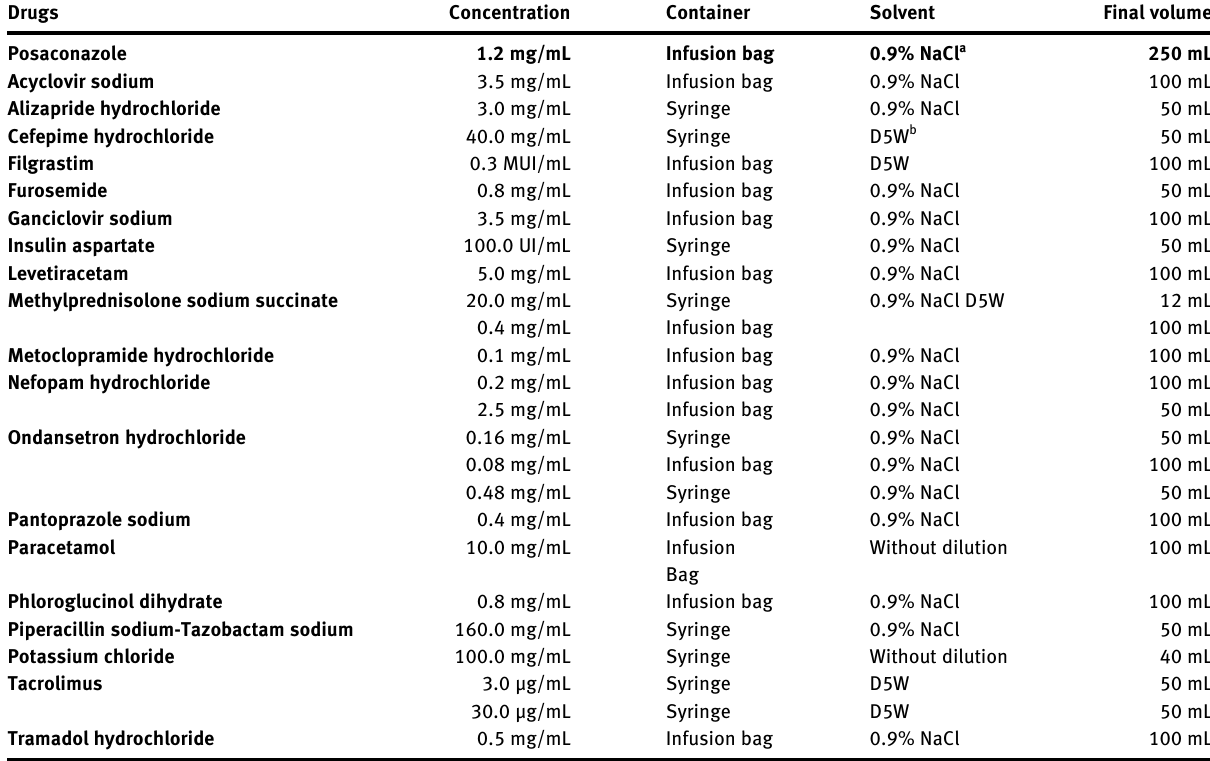
Table  : List of preparations before mixture.